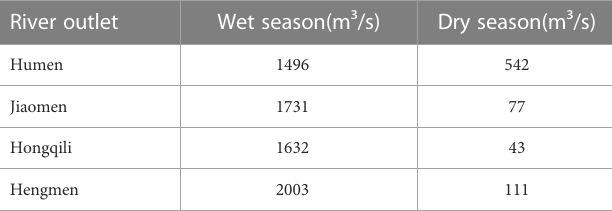
TABLE 1 Discharge at the eight